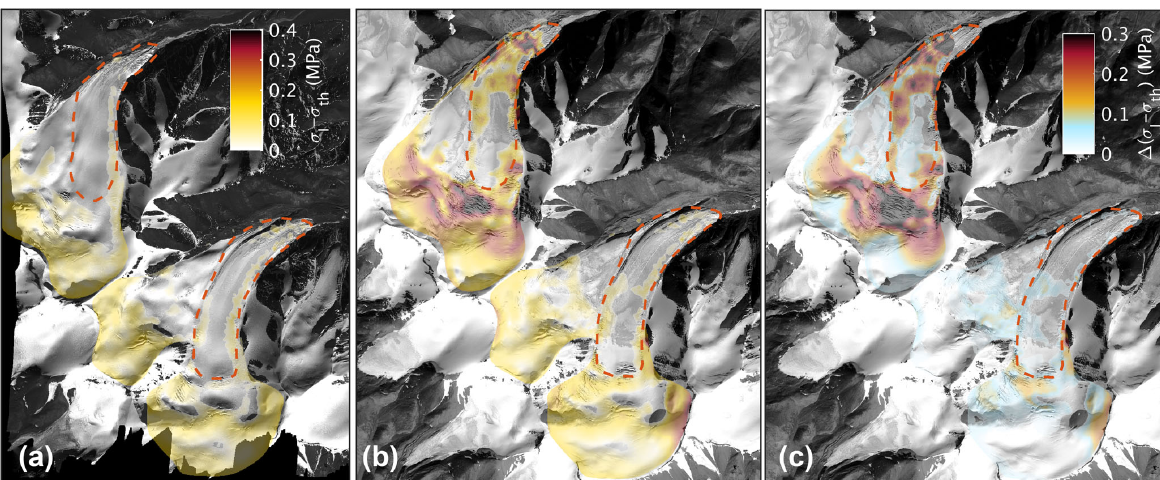
Figure 10. Maximum principal Cauchy stress excess above damage initiation threshold at steady state (a) and prior to collapse (b) at the glacier surface. Panel (c) shows the difference between (a) and (b) . Background image in (a) is a WorldView image from 2 December 2011 when the instability just started. Background image in (b) and (c) is a Spot 7 image from 21 September 2015, 1 year before collapse (copyright Airbus D&S). These results show a good match between predicted and observed crevasse formation in response to frictional